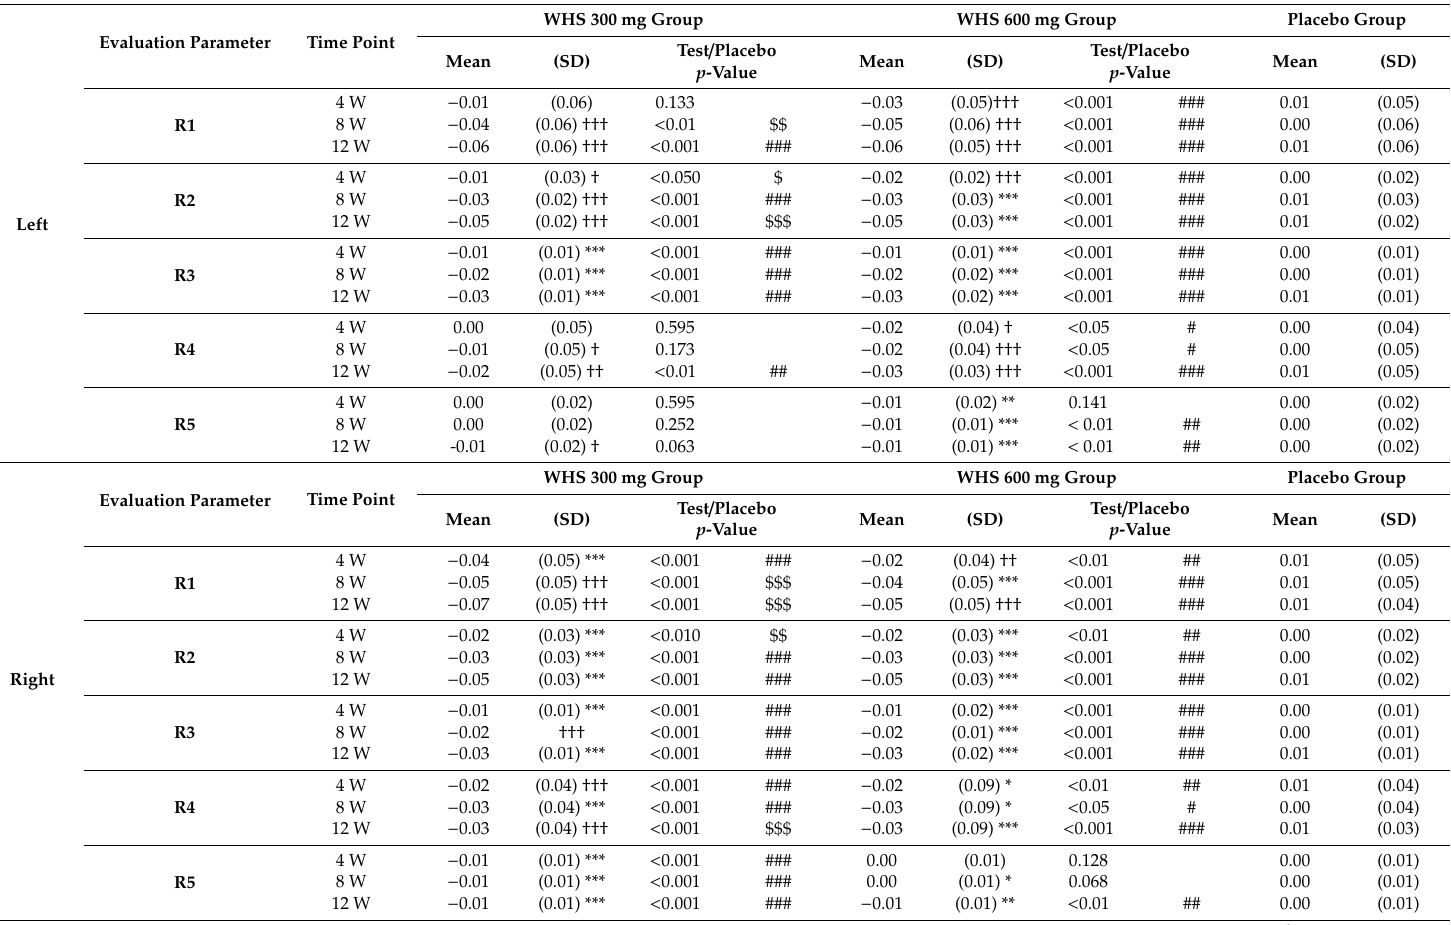
Table 1. Changes of skin-wrinkle parameters measured by Skin Visiometer